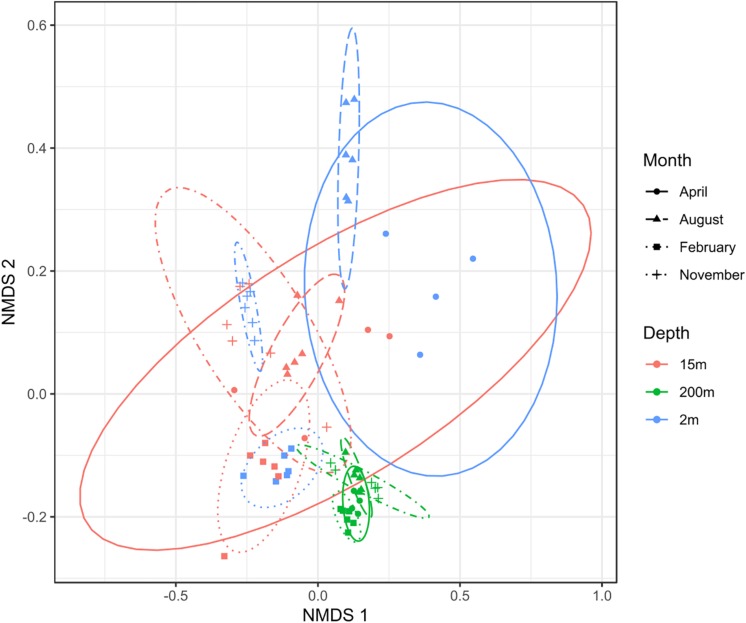
NMDS plot (stress < 0.2) for all sites showing that depth and month variables are responsible for the community dissimilarities.